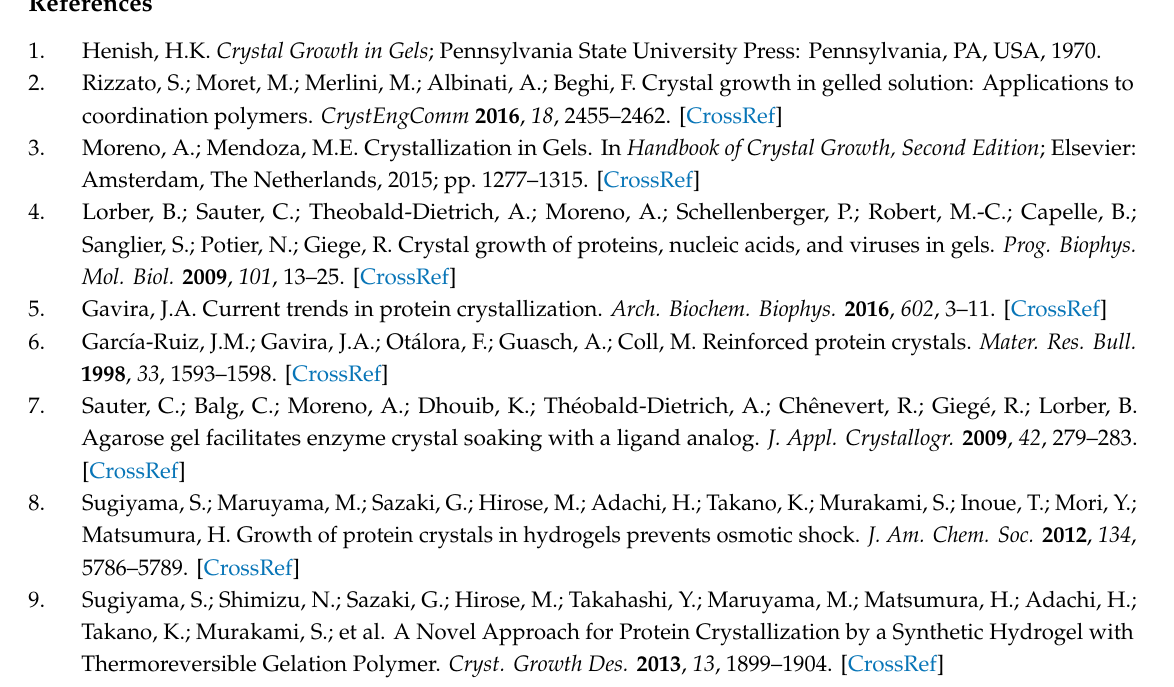
Figure S1: TEM images of dried hydrogels at 0.5% w / v , Figure S2: (A) Fmoc-MF shear strain amplitude; (B) Fmoc-Y shear strain amplitude; (C) Fmoc-MF frequency sweeps; (D) Fmoc-Y frequency sweeps, Table S1 and S4: Summarized the data collection conditions and final statistical values of lysozyme crystals in Fmoc-MF and Fmoc-Y, respectively, compare to agarose hydrogels. Shadowed columns correspond to those already included in the main text; Table S2 and S3: Summarized the data collection conditions and final statistical values of thaumatin and glucose isomerase crystals obtained in Fmoc-MF and in agarose hydrogels. Shadowed columns correspond to those already included in the main